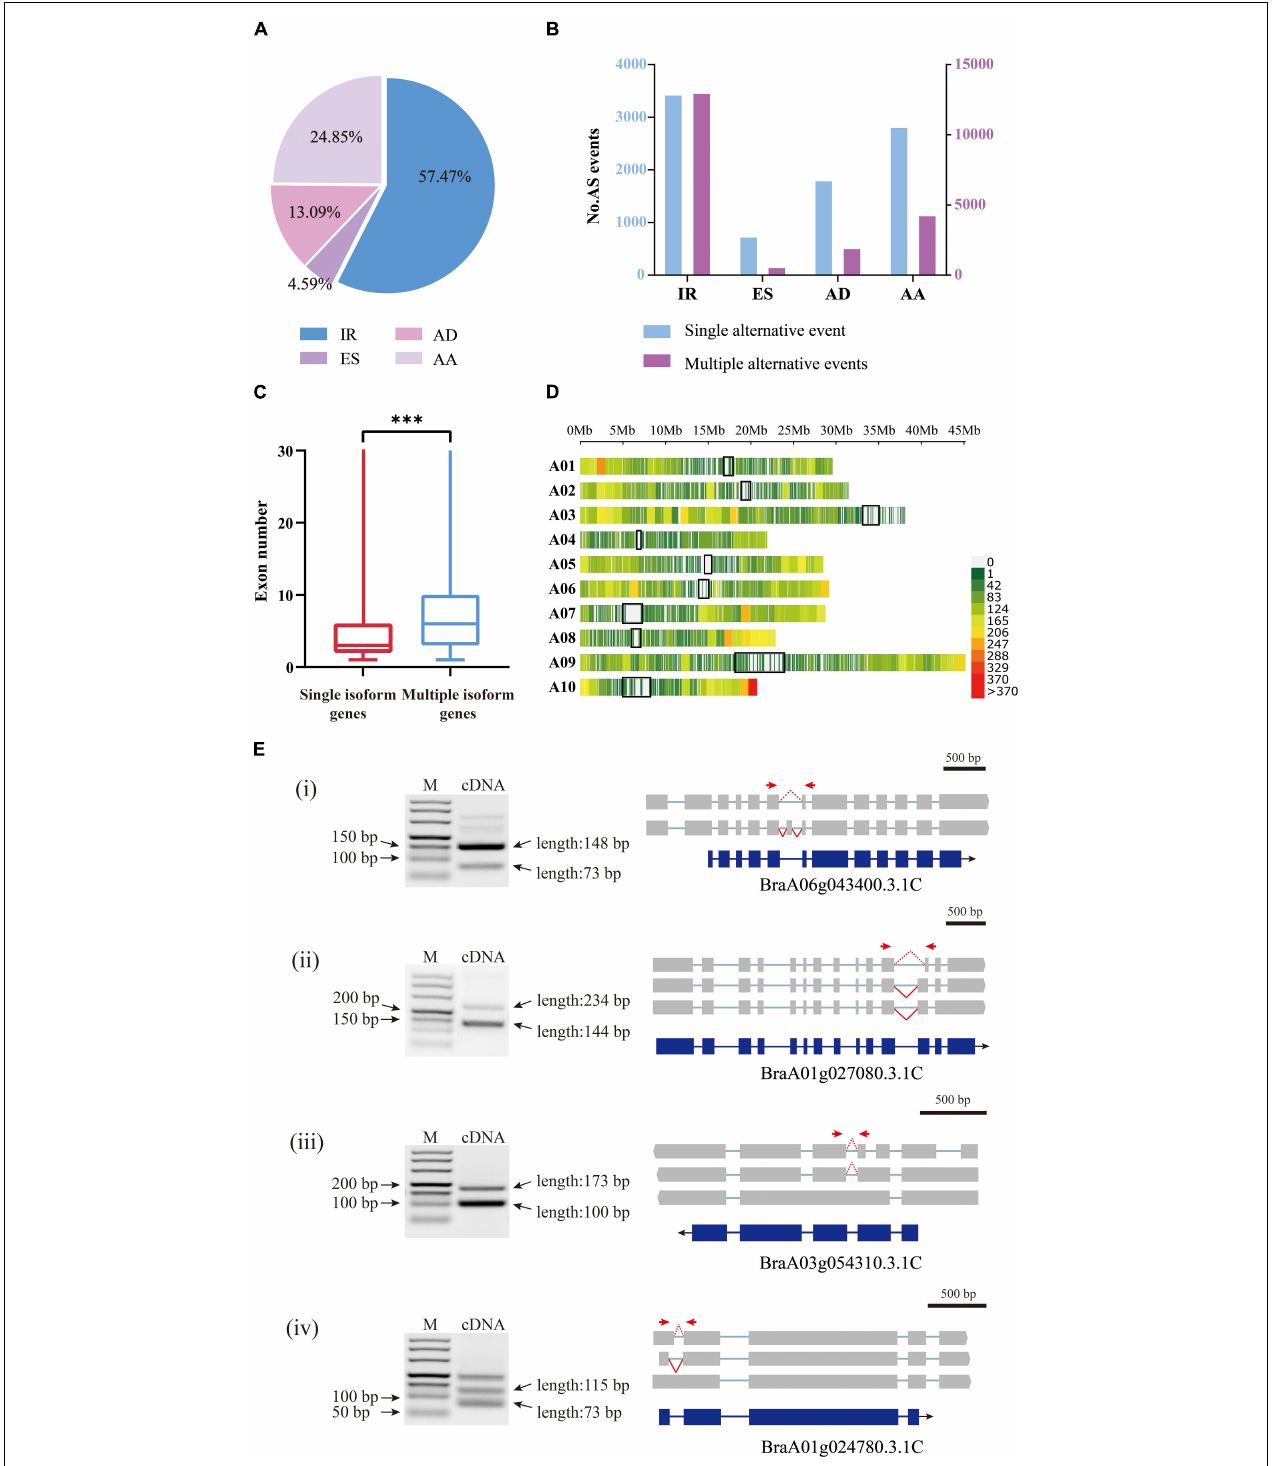
FIGURE 5 | Analysis of alternative splicing events and splice isoforms (A) Proportions of four AS types classified according to biogenesis. IR, intron retention; AD, alternative 5 (cid:48) -donor;ES, exon skipping; AA, alternative 3 (cid:48) -acceptor. (B) In the histograms, transcript variants were sorted into isoforms by single alternative event (blue) and multiple events (red). (C) The exon numbers of genes covered by multiple isoforms and single isoforms. The three stars represent P -value < 0.001. (D) The density distribution of alternative splicing on chromosomes. Gene density was calculated in a 1 Mb sliding window. The black blocks indicate the centromere sites. (E) The RT-PCR validation of AS genes for four typical types. (i) exon skipping; (ii) alternative 3 (cid:48) -acceptor; (iii) intron retention; (iv) alternative 5 (cid:48) -donor. Forward and reverse primers are shown as red arrows. The blue boxes indicate gene CDS, and the gray boxes indicate isoform exons. The red dashed and solid lines indicate different splicing